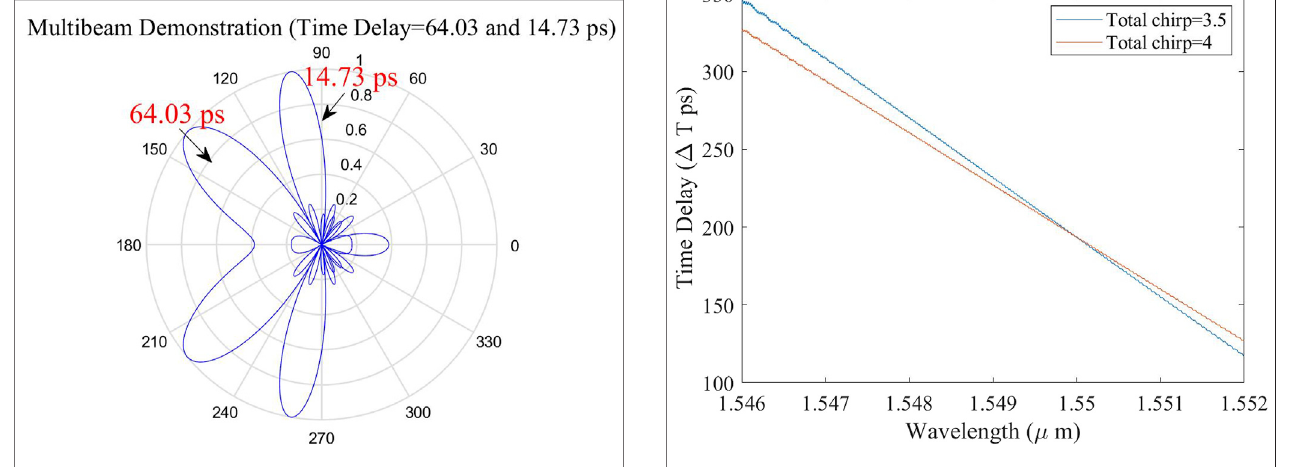
FIGURE 5 | Multi-user beams. FIGURE 6 | Time delay versus wavelength.